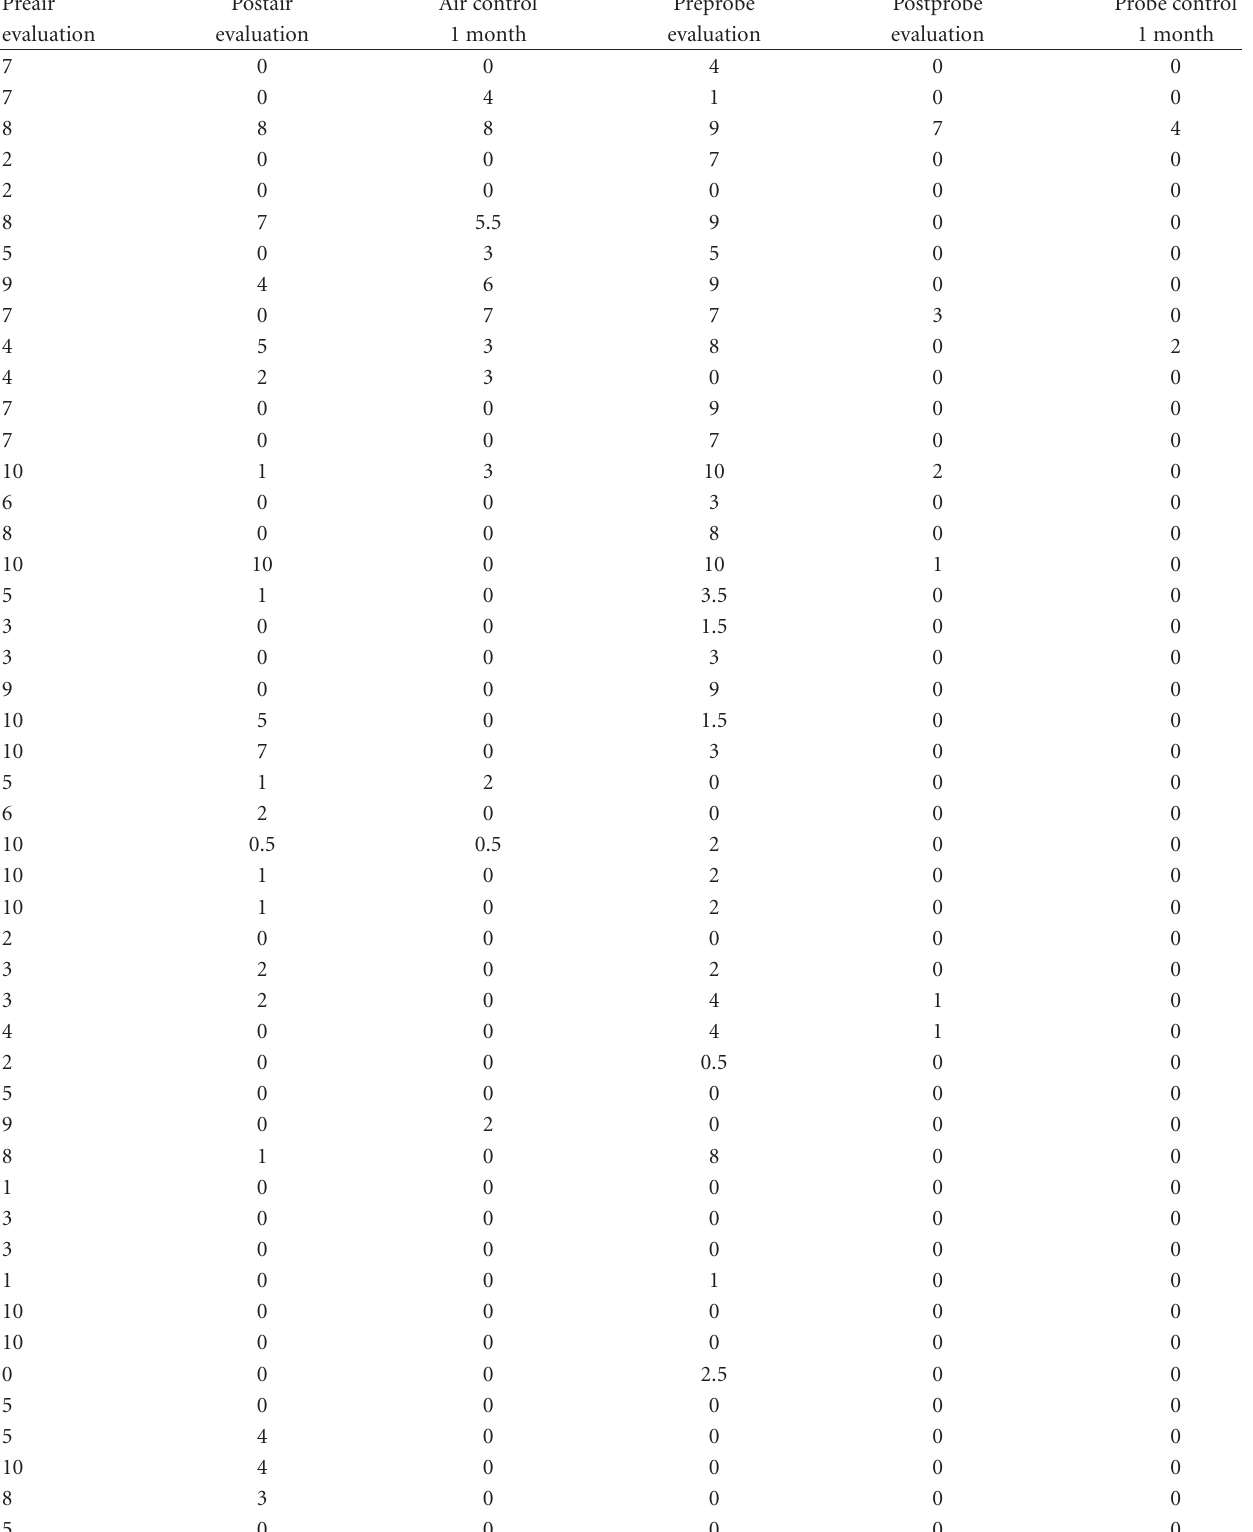
Table 3: Chart of NRS pretreatment, posttreatment, and at 1-month control values of the G3 (NaF gel + Diode laser). Preair Postair Air control Preprobe Postprobe Probe control